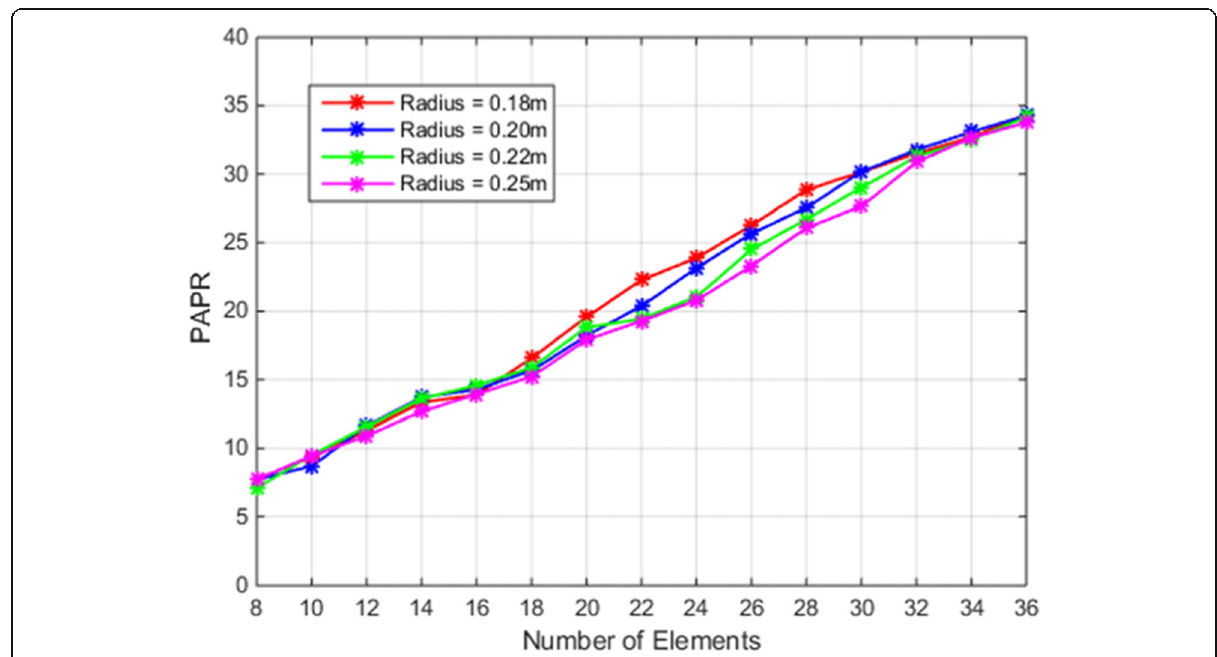
Fig. 7 Peak to average power ratio versus different numbers of